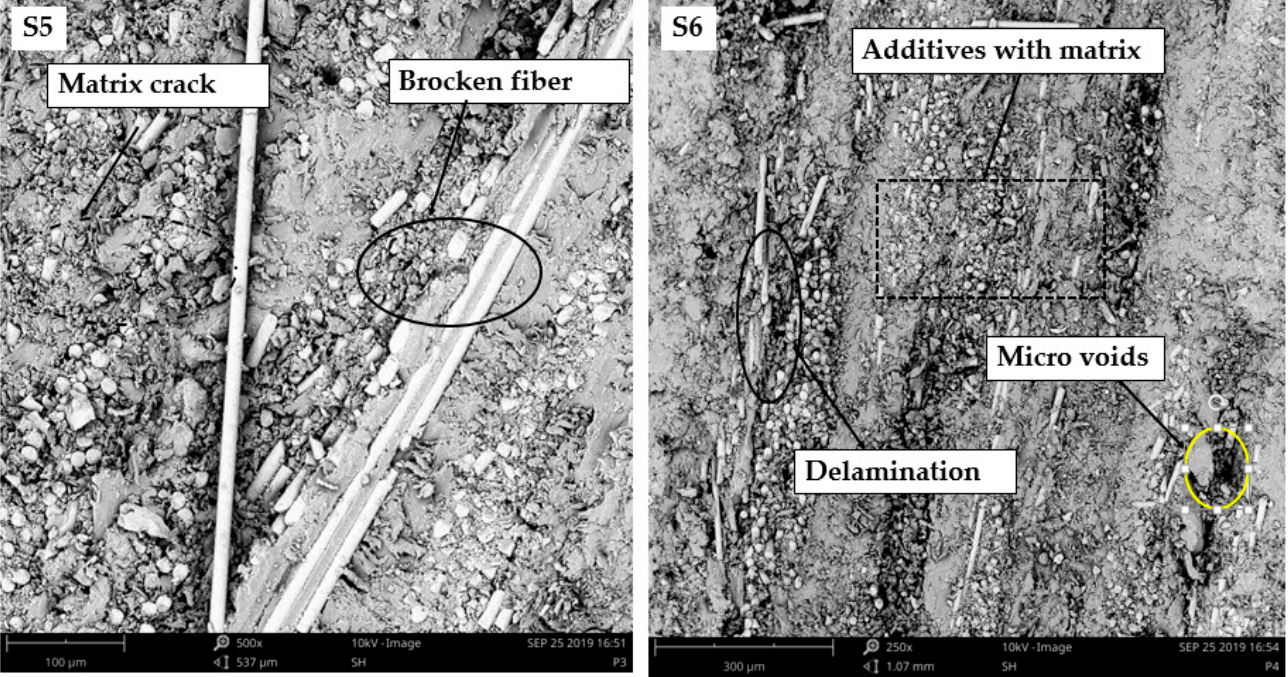
Figure 8. SEM images of the S5 and S6 hybrid composites after flexural test.